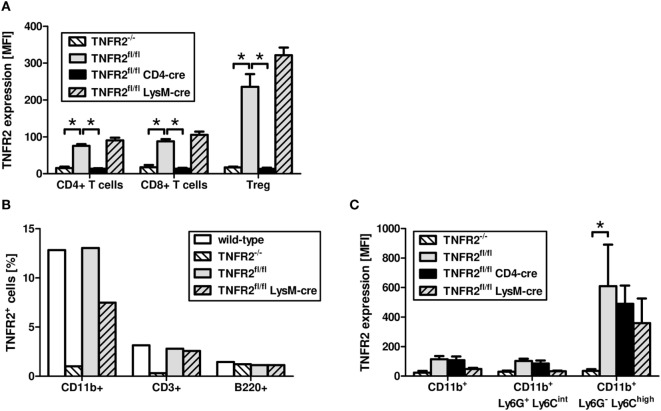
Expression of TNFR2 on cells from genetically modified mouse lines. Splenocytes of naïve male mice of each mouse genotype were analyzed by flow cytometry for the expression levels [mean fluorescent intensity (MFI)] of TNFR2 on CD4+, CD8+, and Treg (CD4+Foxp3+) cells (A). The frequency of cells expressing TNFR2 on CD11b+, CD3+, and B220+ cells was analyzed by flow cytometry (B). Bone marrow cells of naïve male mice of each mouse genotype were analyzed by flow cytometry for the MFI of TNFR2 expression on two subtypes of CD11b+ myeloid cells, PMN-MDSC (Ly6G+Ly6Cint), and MO-MDSC (Ly6G−Ly6Chigh) (C). Results derived from three individual mice per group are expressed as mean values + SD. The data are representative of one out of three experiments.